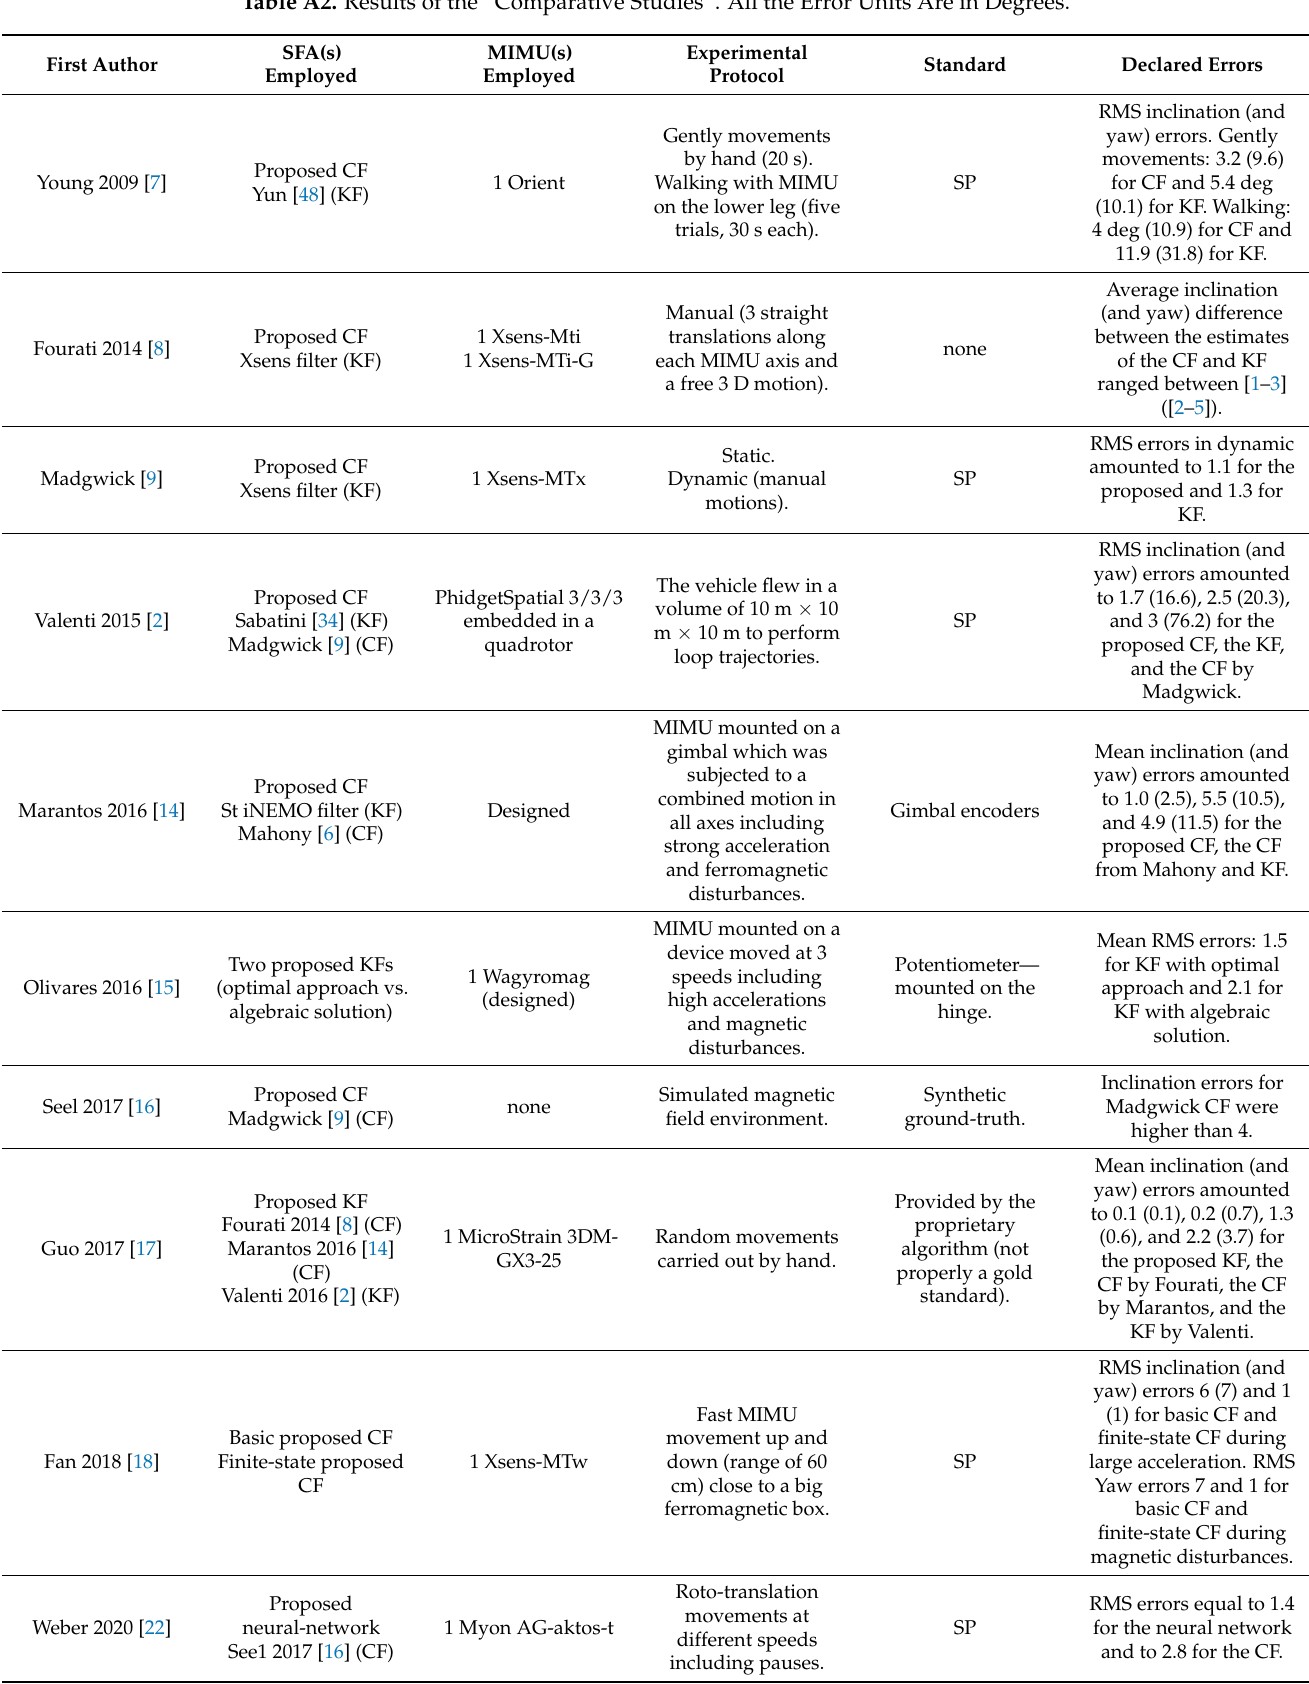
Table A2. Results of the “Comparative Studies”. All the Error Units Are in